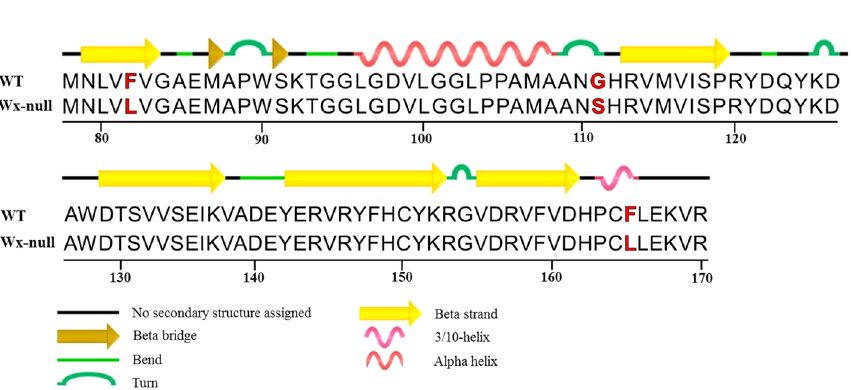
Figure 5. Analysis of Wx-D1 gene sequences in wild-type and Wx-null line. Black and white boxes respectively indicate exons and introns. Numbers show base position. SNP is indicated by the shaded area.